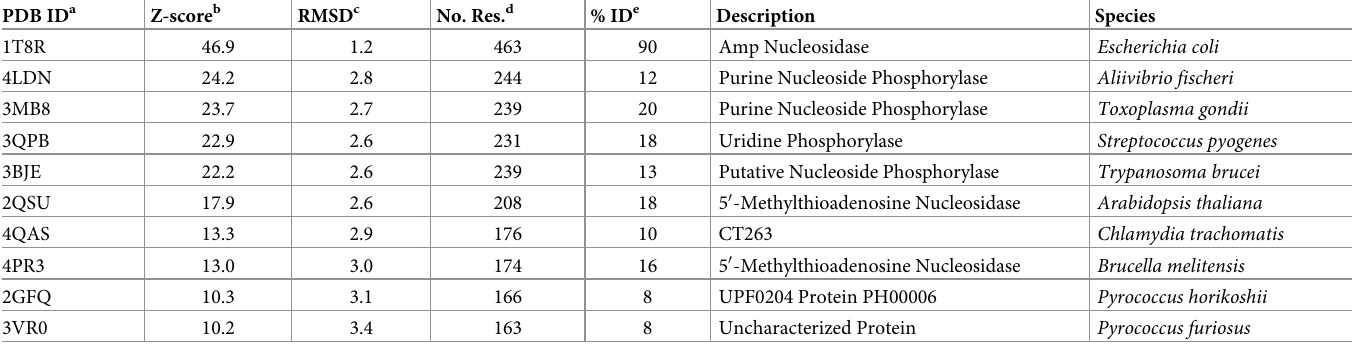
Table 1. Structure comparison results. Pairwise structure comparison of KpAmn to all structures in the Protein Data Bank as of March 2022 (the top 10 of 43 total results are given). Further alignment details are provided in S2 Fig. PDB ID